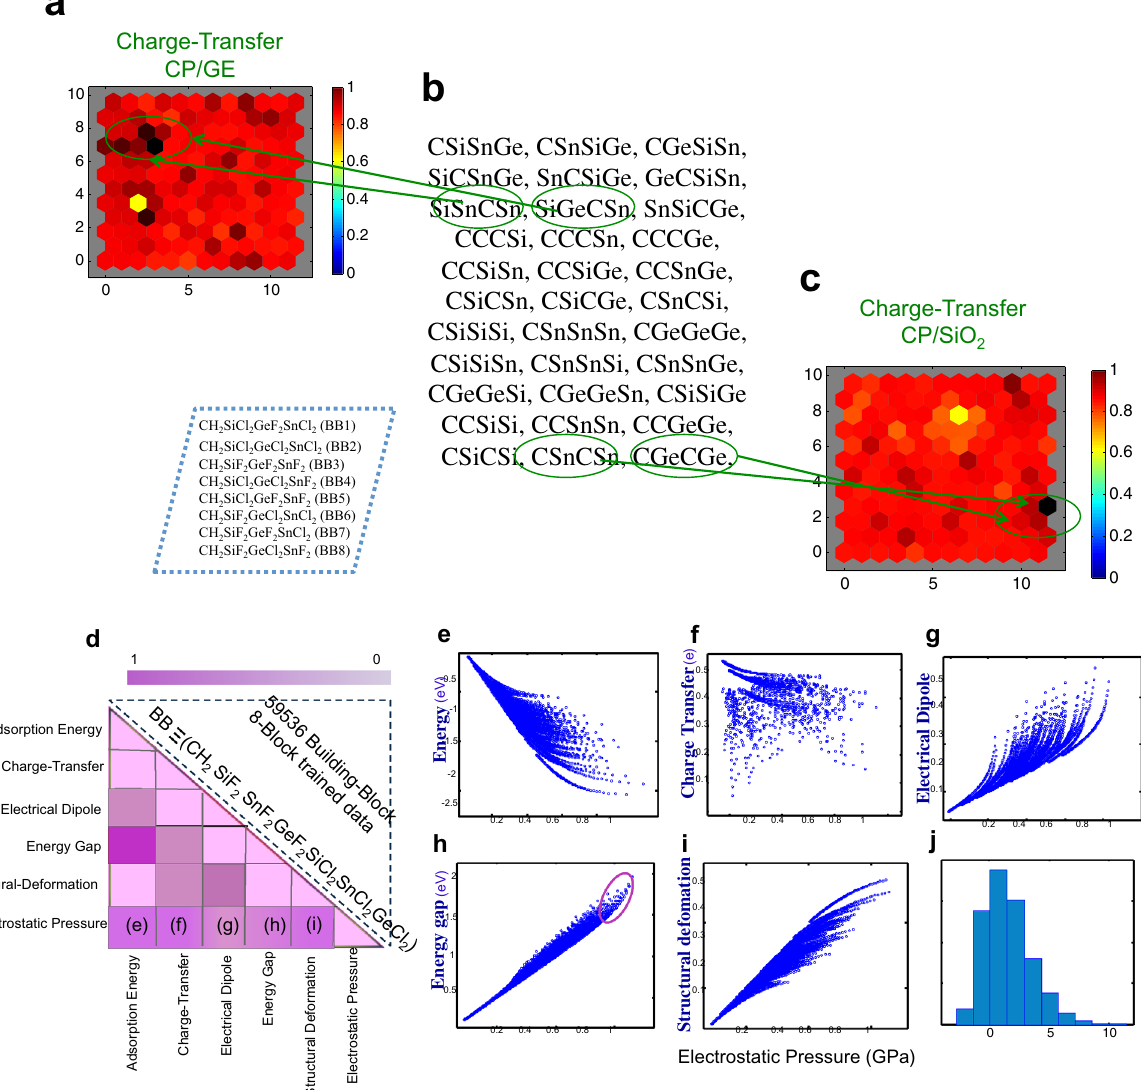
Figure 5. Pathway of predictions and correlations from machine learning. (a–c) High throughput prediction from neural network and machine learning of 4-block CPs/GE. ( a) The green circles indicate material discovery related to large charge transfer and pressure for CPs/GE (Fig. 4). ( b) The middle panel presents several atomistic model for chain polymer adsorbed on two substrates, where different functional group as BB1….BB8 is located in dashed rectangular, and ( c) related to large charge transfer and structural deformation for CPs/SiO 2 (Figure S14III). ( d–j) Correlation map between different interfacial properties of 1D chain polymer adsorbed on graphene layer for 8-block trained data. ( d) The triangle presents the possible building blocks of 8-block chain polymers. This map reveals that correlation of electrostatic pressure with other interfacial properties is dominant. Panels ( e–j) indicate the correlation of pressure with ( e) adsorption energy, ( f) charge transfer, ( g) electrical dipole moment, ( h) energy gap, ( i) structural deformation and ( j) histogram of pressure. The purple circle in panel (h) indicates systems with a simultaneously large energy gap and large